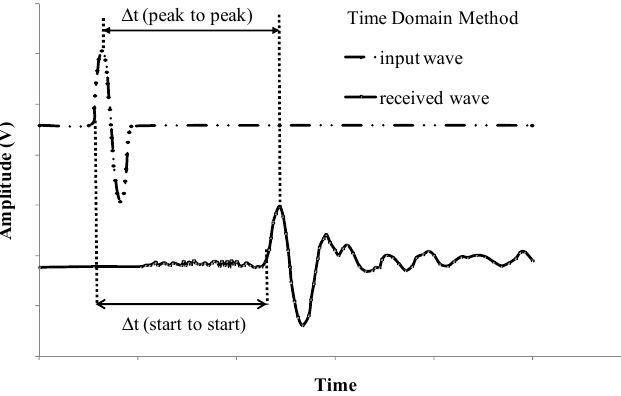
Figure 5. Typical identification techniques of travel time in the time domain method.